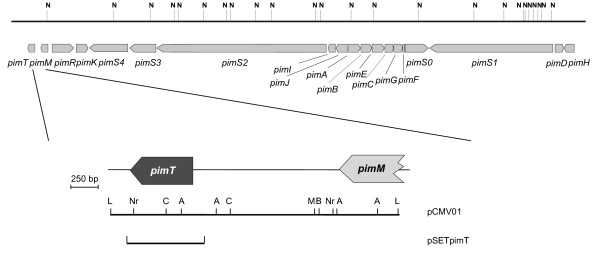
Pimaricin biosynthetic gene cluster. The left fringe of the gene cluster is indicated in more detail, and includes pimT (in dark grey), and the 3'-end of the transcriptional activator-encoding gene for pimaricin biosynthesis pimM [26]. Pointed boxes indicate the direction of transcription. A, ApaI; B, BamHI; C,AccI; L, ApaLI; M, MluI; N, NotI; Nr, NruI. The inserts used for vector construction are indicated at the bottom.